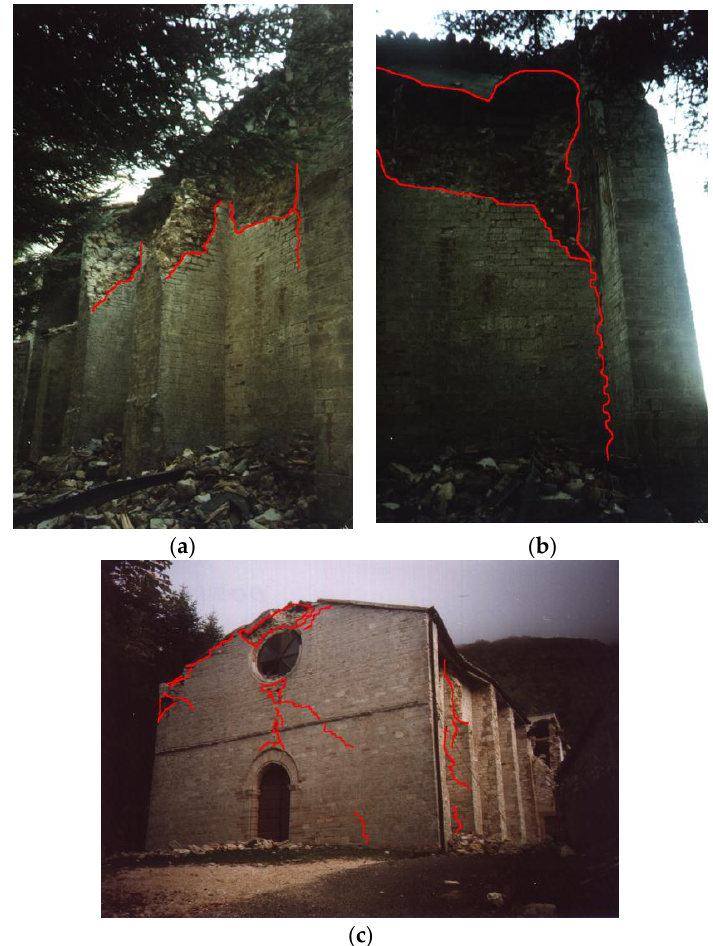
Figure 13. Post-1997 earthquake damage of the exterior of the church. Photo source [56]. ( a ) Collapse of the upper part of the buttresses and of the lateral walls; ( b ) partial collapse of the north wall of St. Salvatore church; ( c ) damaged gable, left portion of the upper side of the façade, shear crack in the central part under the rose window and collapse of the upper portion of the buttresses of the south